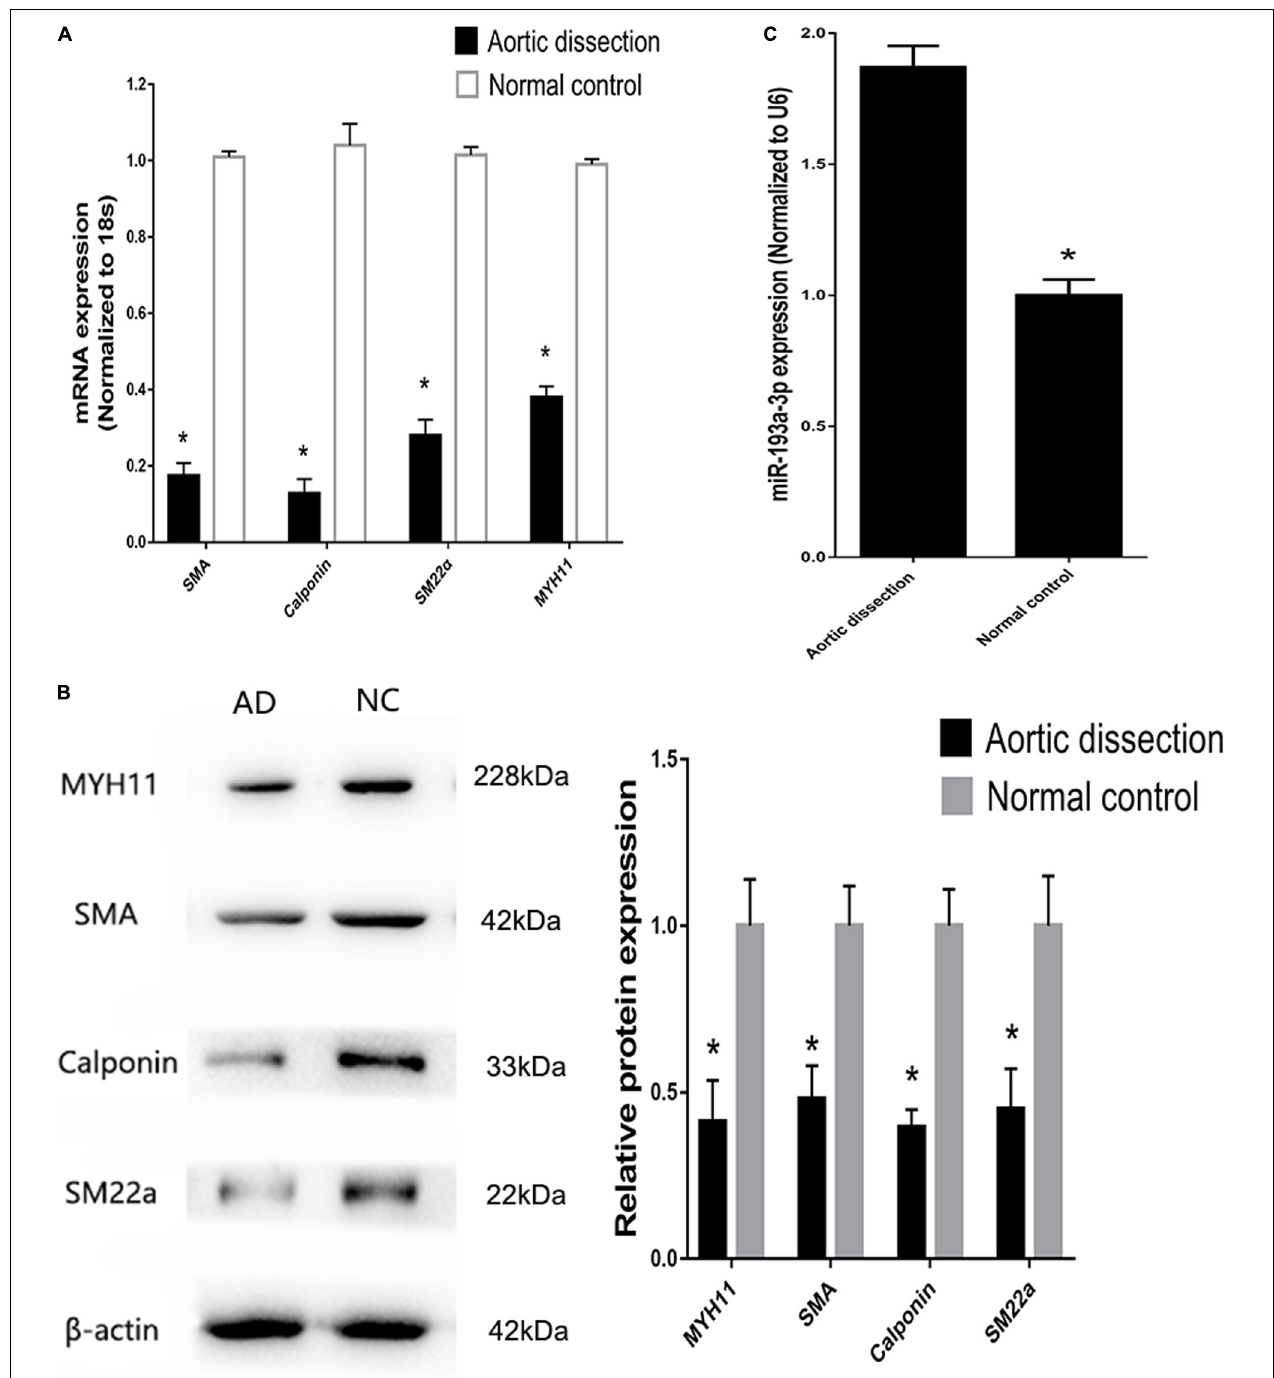
FIGURE 4 | Increase of miR-193a-3p levels in tissues from patients with aortic dissection (AD). (A) Quantitative reverse transcription-polymerase chain reaction (qRT-PCR) showed a decrease in VSMC differentiation biomarkers in AD tissues ( n = 10). * P < 0.05. (B) Western blot analysis showing downregulation of VSMC differentiation biomarkers in AD tissues ( n = 3). * P < 0.05. (C) miR-193a-3p was upregulated in human AD